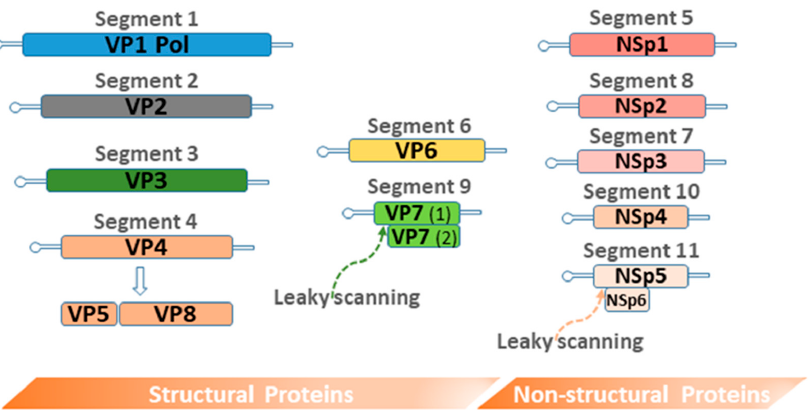
Figure 1. Rotavirus genome structure.